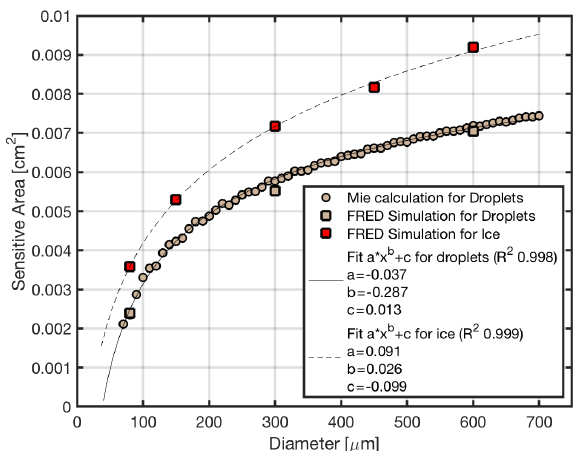
Figure 10. Sensitive area based on FRED simulations for ice (red) and droplets